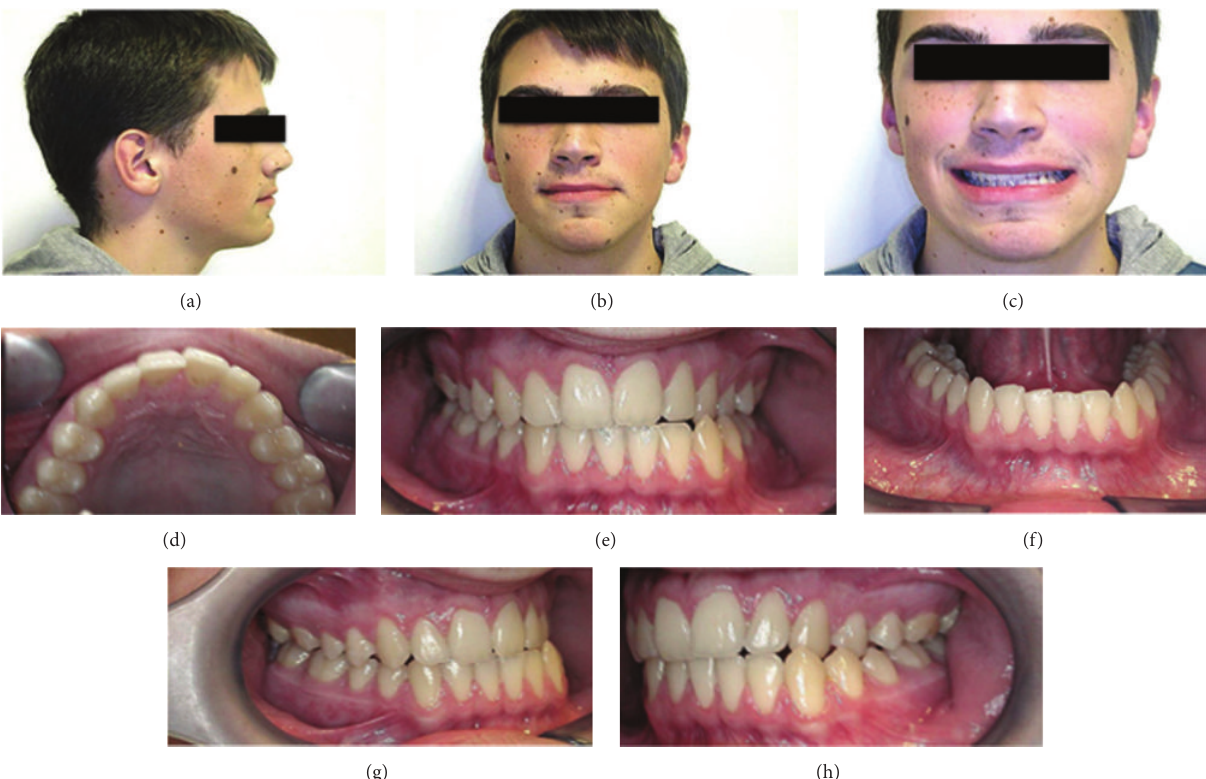
Figure 1: Preoperative clinical evaluation. ((a), (b), (c)) Extraoral evaluation; ((d), (e), (f), (g), (h)) intraoral evaluation.